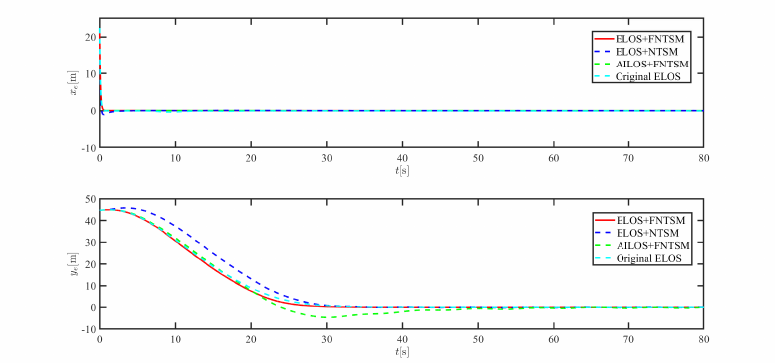
Figure 16. Comparison results of curve line trajectory tracking at moderate speed.